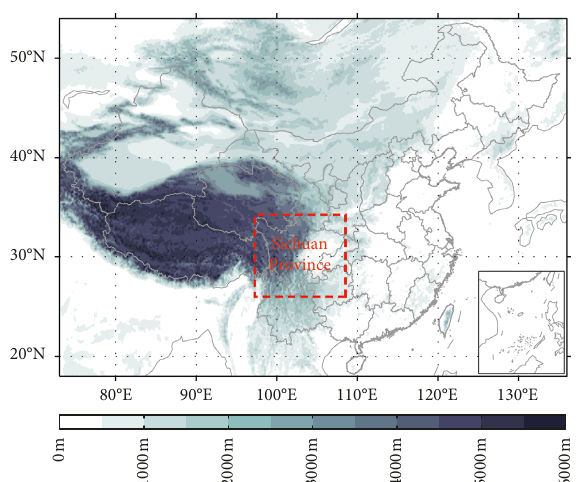
Figure 1: Map of terrain elevations (shaded every 1000m) in eastern Eurasia and the region of Sichuan Province in the red dashed